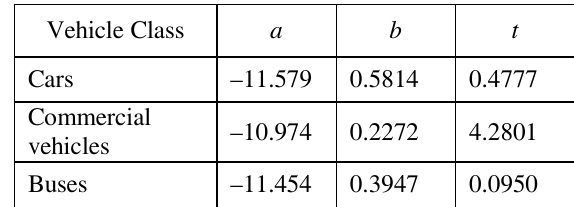
Table 2. Parameters of the